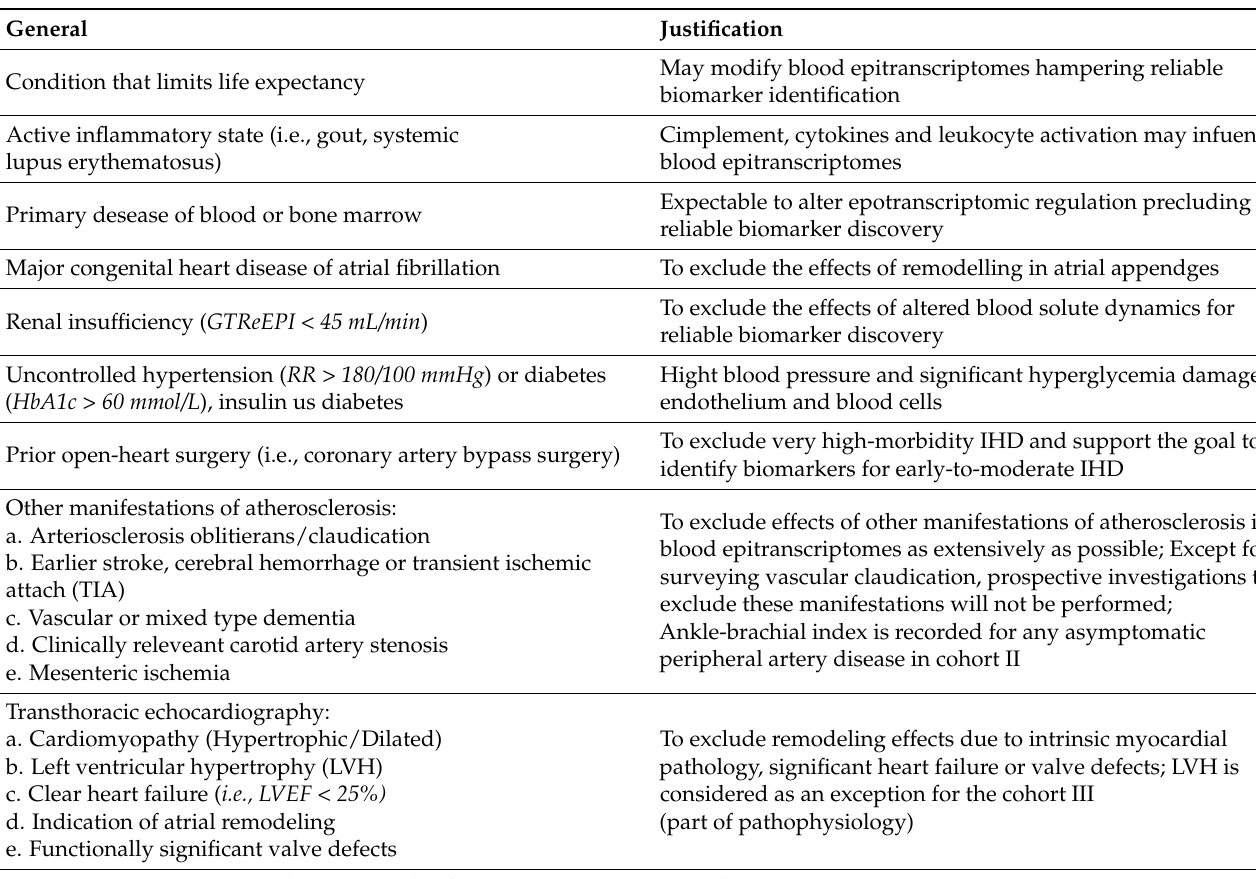
Table 2. General and cohort-specific exclusion criteria for the IHD-EPITRAN study. CCS , Canadian cardiovascular society (for angina pectoris grading); GFReEPI , Glomerular filtration rate estimated with CKD-EPI (Chronic Kidney Disease Epidemiology Collaboration) equation; IHD , ischemic heart disease; LVEF , left ventricular ejection fraction; LVH , left ventricular hypertrophy; NYHA , New York Heart Association (for heart failure grading); PCI , percutaneous coronary intervention; RR , Scipione Riva-Rocci (eponym for sphygmomanometric blood pressure